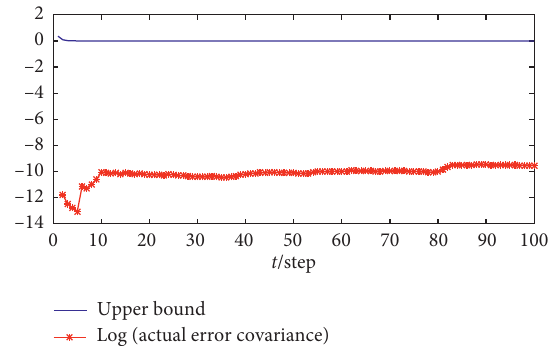
Figure 4: Log (actual estimation variances) of the first state and its upper bound.